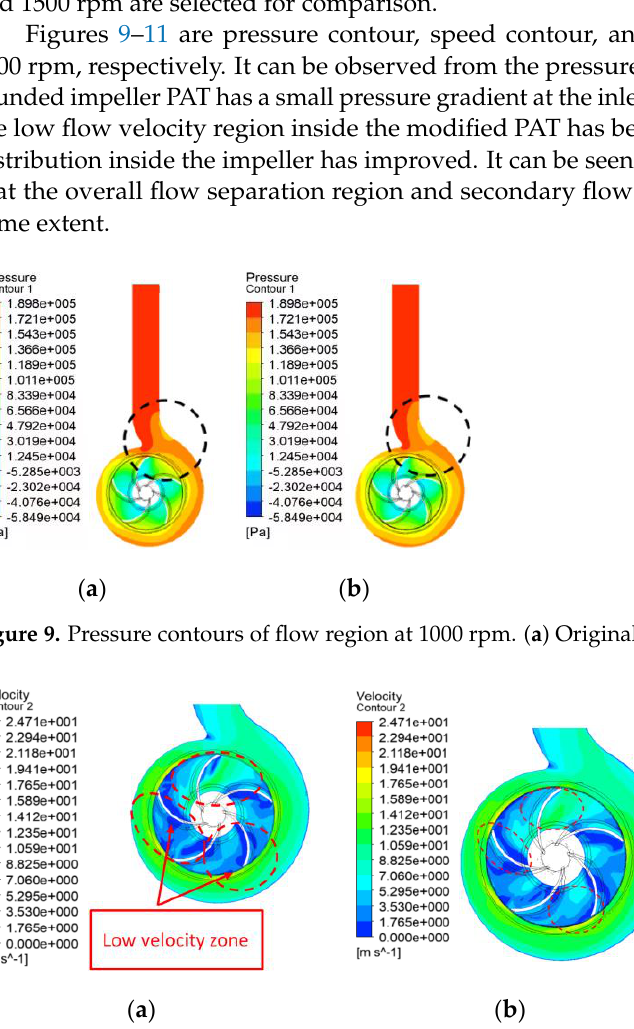
11 of 16 Figure 8. Reynolds number versus efficiency curves at 1000 rpm, 1250 rpm, and 1500 rpm.